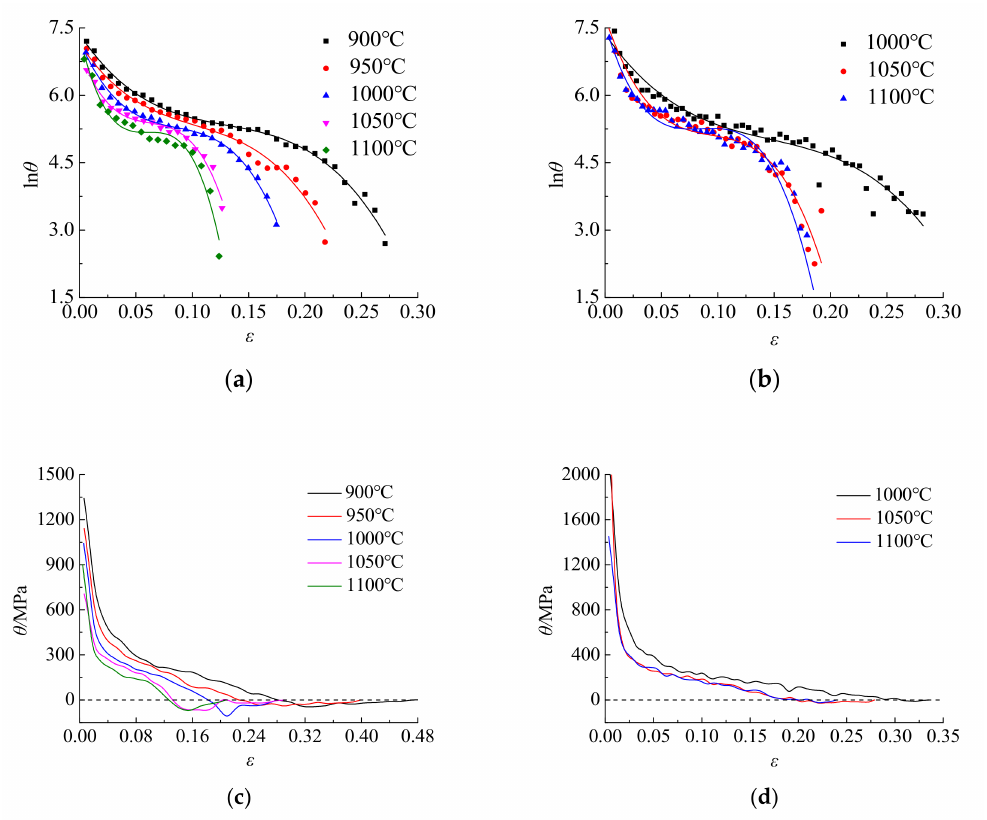
. ε = 0.01 s − 1 ); ( b ) In θ - ε (